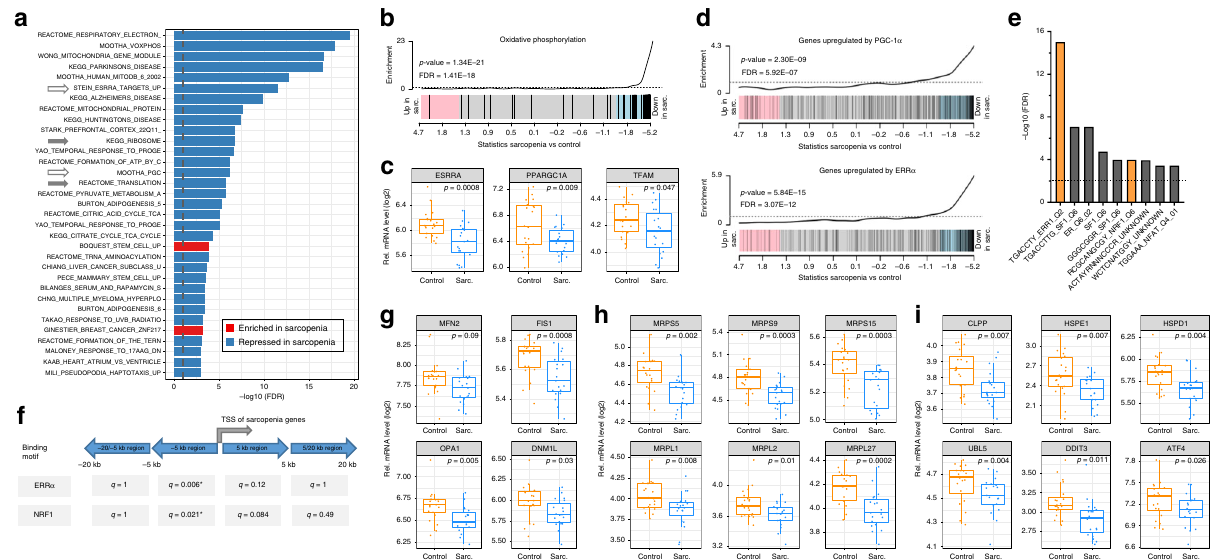
Fig. 2 Mitochondrial dysfunction is the major transcriptional change during sarcopenia in SSS. a Gene-set enrichment analysis of sarcopenic vs control muscle using CAMERA and the C2 curated gene set collection from MSigDB. Gene sets are ordered according to the signi fi cance of their enrichment; only gene sets with an FDR < 0.1% and a gene overlap < 75% are represented. White arrows highlight gene sets linked to the transcriptional regulation of mitochondrial function; gray arrows highlight gene sets linked to protein synthesis. b Enrichment plot for the oxidative phosphorylation gene set “ Mootha_VOxPhos; M18264 ” . c mRNA expression of transcriptional regulators of mitochondrial function in SSS sarcopenic vs. control muscle. d Enrichment plot for PGC-1 α target genes and ERR α target gene set ( “ Mootha_PGC1a; M9788 ” and “ Stein_ESRRa_Up; M18491 ” ). e Transcription factor binding site enrichment of the 4 kb promoters of genes regulated in sarcopenic muscle at FDR q -value < 0.05. x -axis represents the MsigDB transcription factor gene sets that passed the signi fi cance threshold. f ERR α and NRF1 binding motif in the proximal and distal regions fl anking the transcriptional start site (TSS) of the genes regulated in sarcopenic muscle at FDR q -value < 0.05. Benjamini Hochberg-corrected median-adjusted q -values were computed by performing 1000 hypergeometric test permutations. g – i mRNA expression of genes regulating mitochondrial dynamics ( g ), mitochondrial ribosomal protein genes ( h ), and UPRmt genes ( i ) in SSS sarcopenic vs. control muscle. In c , g – i , nominal p values of the moderated t-statistic are reported. For all panels, n = 19 – 20 muscle samples per group from SSS